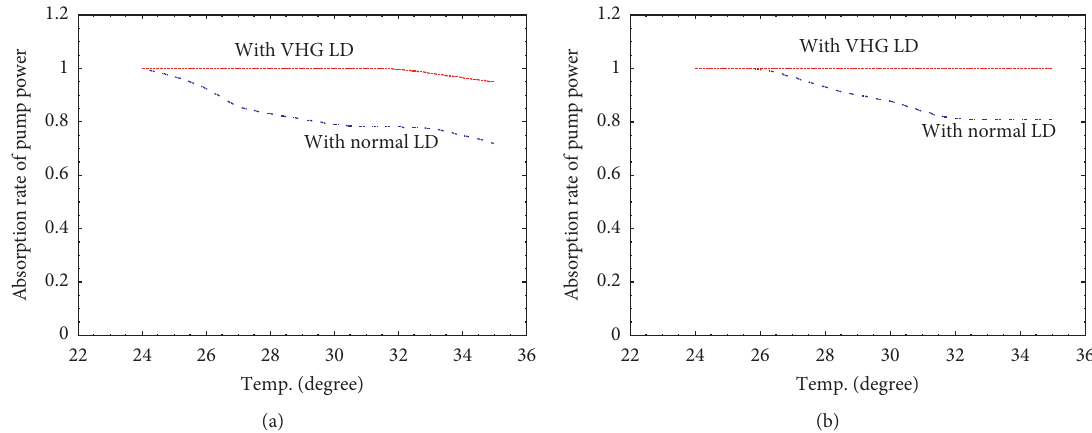
Figure 6: Absorption ratio of laser materials as a function of LD temperature: (a) Nd:YAG and (b) Nd:YVO